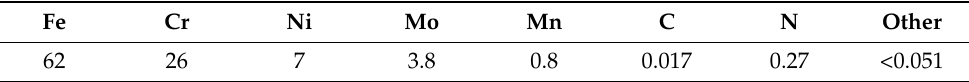
Table 1. Chemical composition of UNS S32750 superduplex stainless steel (wt %) measured by combustion (infrared absorption for C), combustion (conductimetry for N), and by X-ray fluorescence for the rest. Fe Cr Ni Mo Mn C N Other 62 26 7 3.8 0.8 0.017 0.27